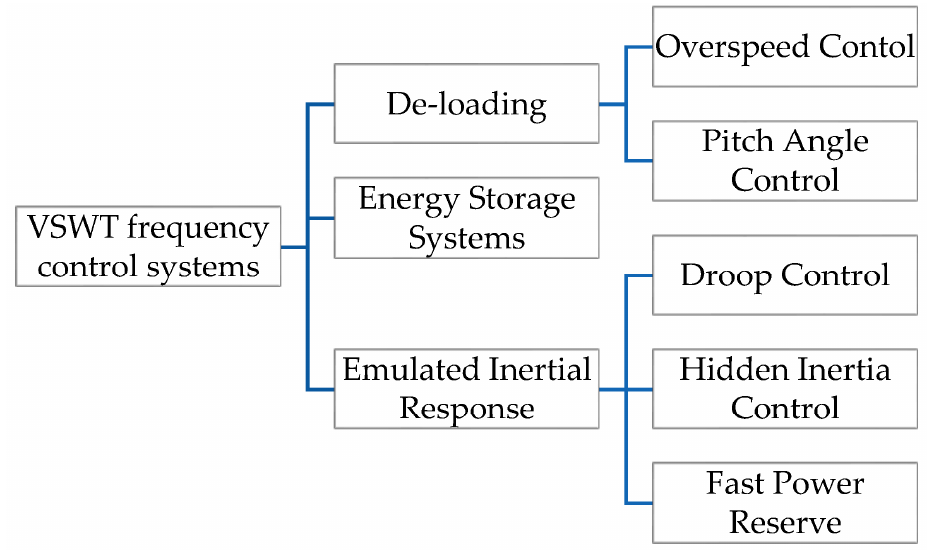
Figure 1. Classification of variable-speed wind turbines frequency control system [7] .